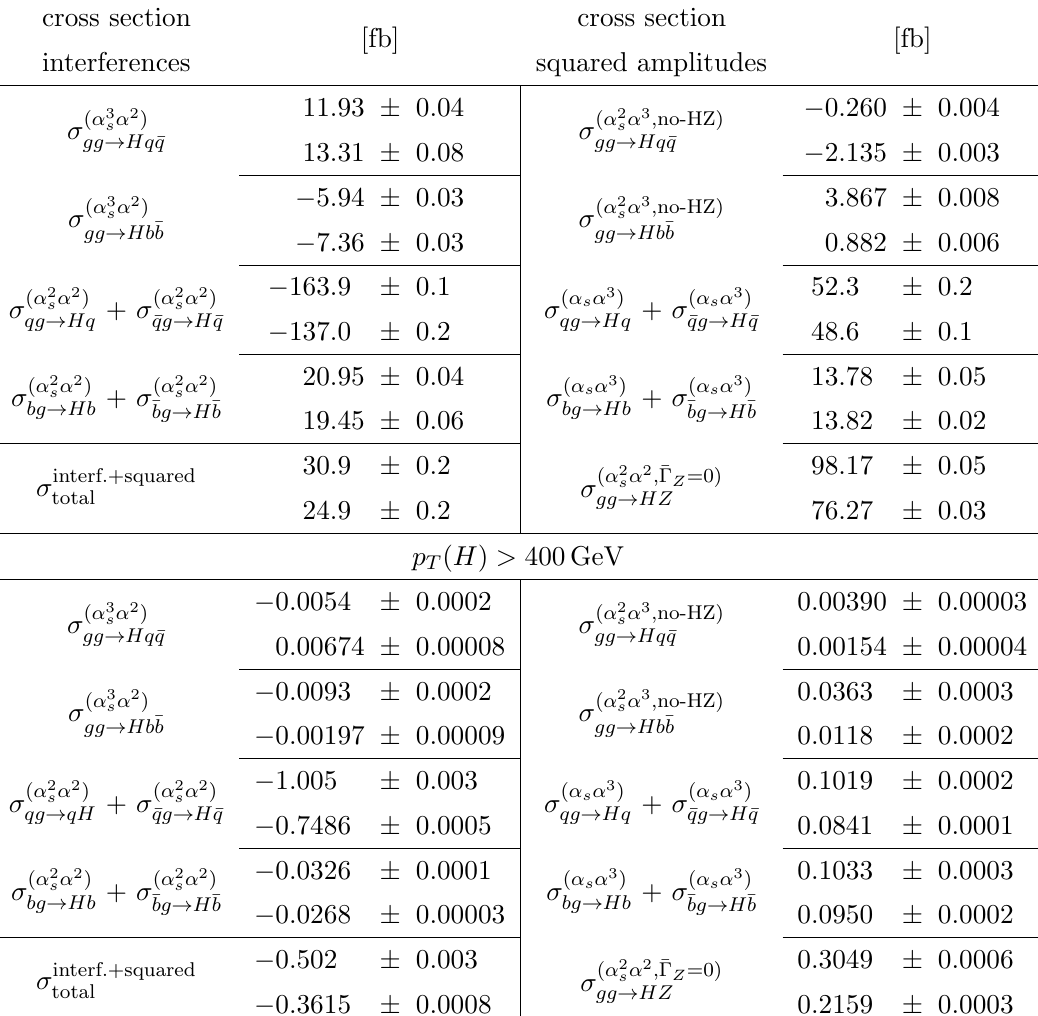
Table 3 . Fully and semi inclusive cross sections at LHC13 obtained with SM input